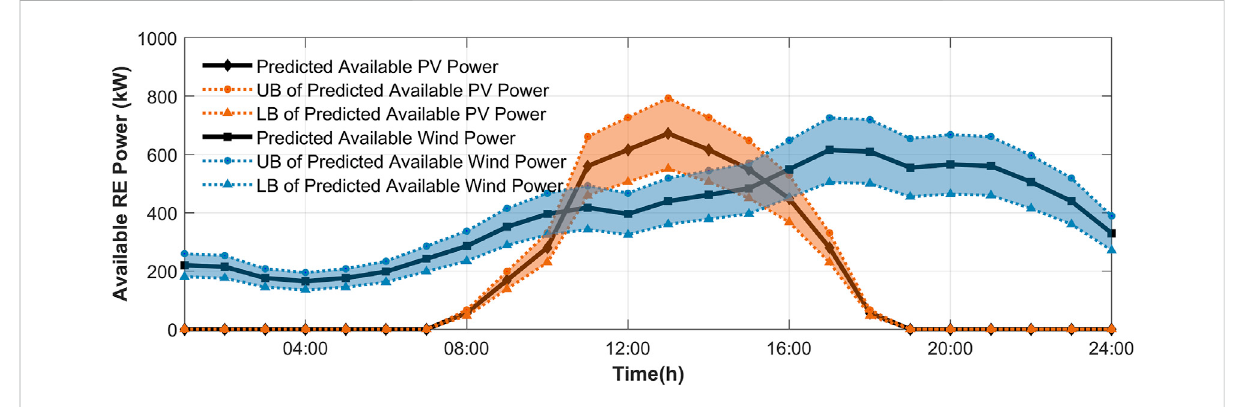
FIGURE 7 MEMG available RE power predicted, and uncertainty